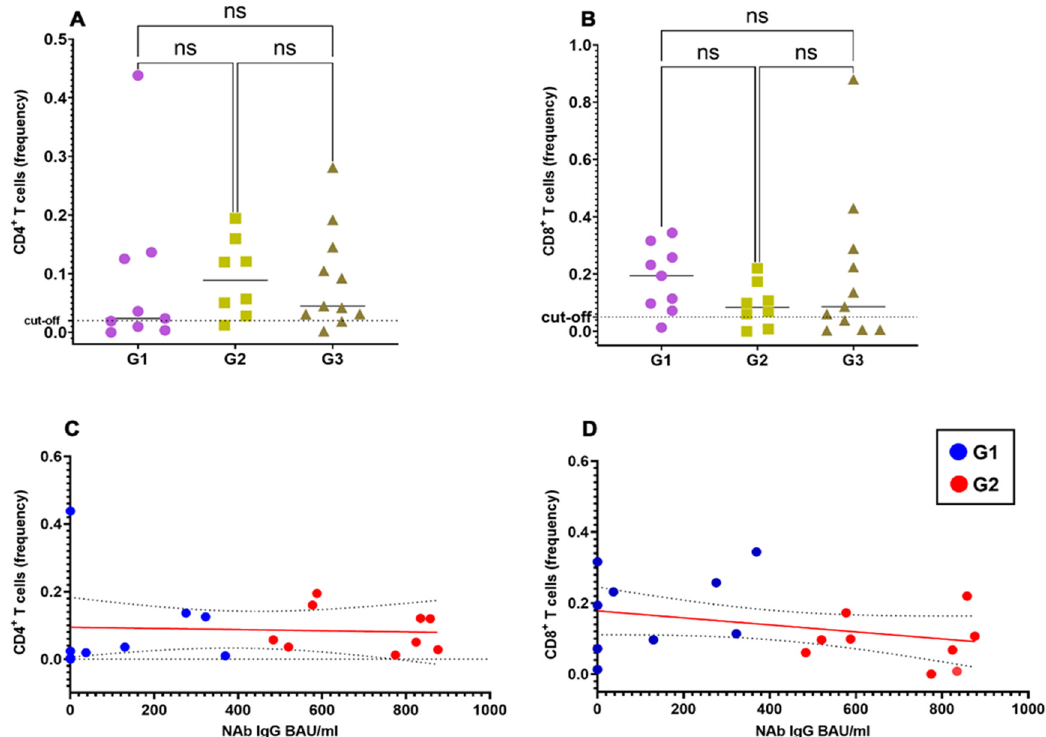
Figure 2. Correlation of spike-specific CD4 + and CD8 + T cells with spike-specific NAb titers. Frequencies of spike-specific CD4 + ( A ) and CD8 + ( B ) T cells upon stratification of vaccinated individuals in 3 different groups according to their SARS- CoV-2 NAb titers (groups G1 to G3). Pearson correlation coefficient with one-tailed P-value and 90% confidence interval between titers of SARS-CoV-2 NAbs and the frequency of spike-specific CD4 + ( C ) and CD8 + ( D )T cells. Table 3. NAb titer and frequency of responder T cells in patients with B cell deficiencies. Enrolled